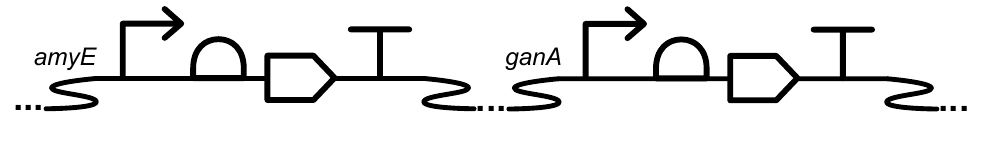
Figure 10. Any glyphs for a feature associated with the inline strand SHOULD be placed in the prototypical orientation given by the specification, while any glyph that is associated with the reverse complement strand SHOULD be inverted vertically and horizontally (i.e., rotated 180 degrees). Reverse complement MAY also